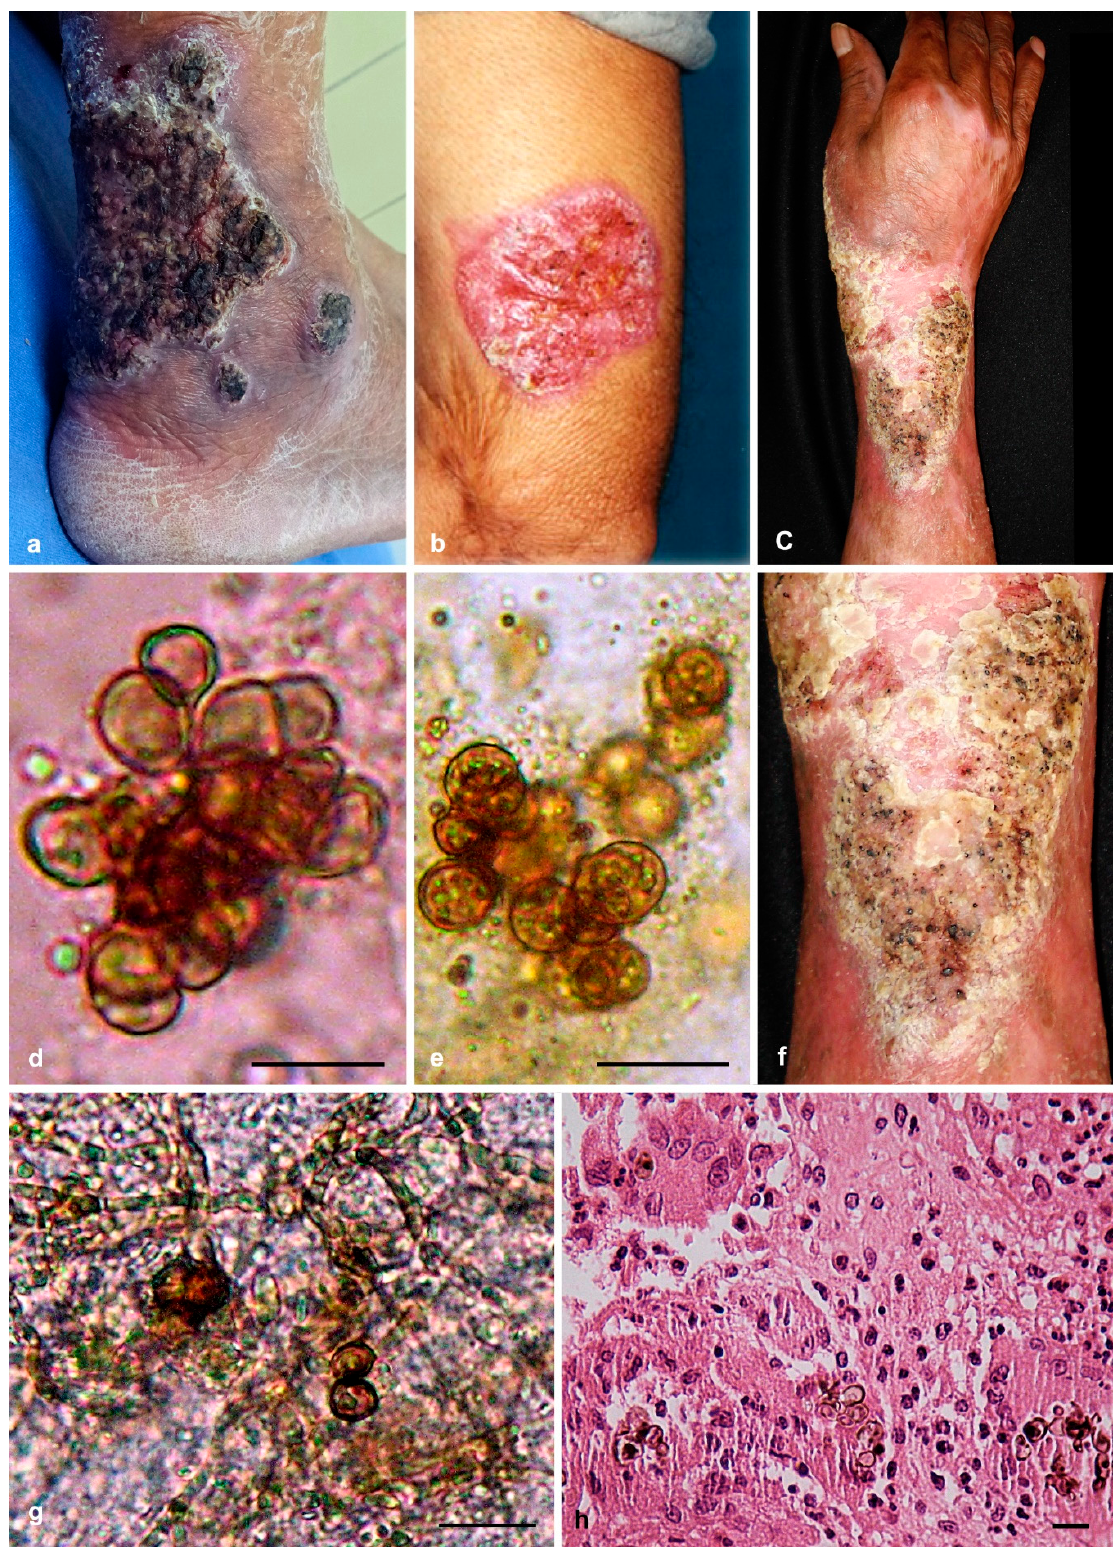
Figure 1. Clinical presentation, direct examination, and histology of Phialophora cases. ( a , d ) The case of Phialophora americana ; ( b , e ) The case of Phialophora chinensis ; ( c , f – h ) The case of Phialophora macrospora . Scale bar = 10 µm.